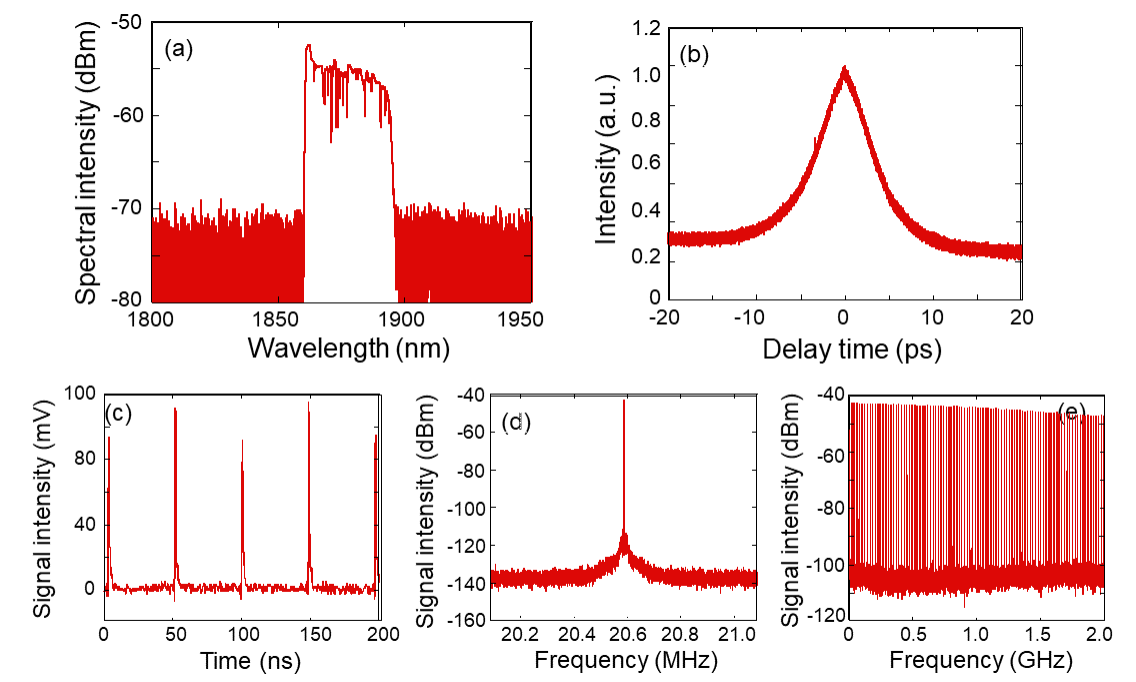
Figure 8. Characteristics of output pulses when D = +0.0503 ps 2 and spectral filter was not used, ( a ) optical spectra, ( b ) autocorrelation trace, ( c ) pulse train, ( d , e ) RF spectra of ( d ) fundamental frequency and ( e ) wide range.